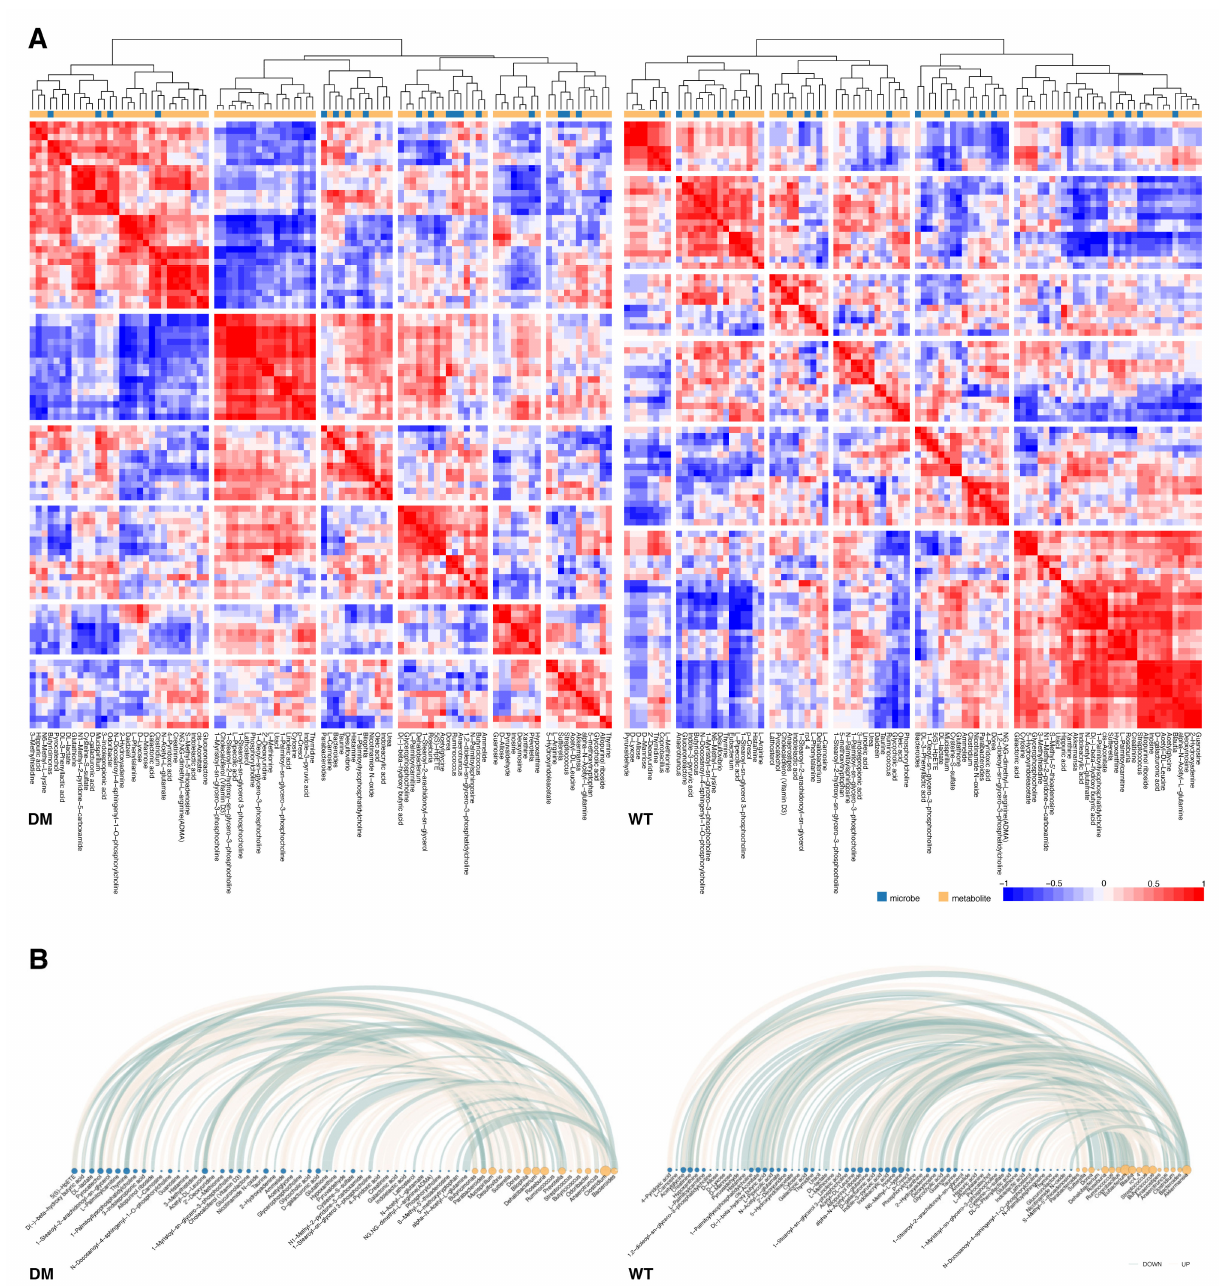
Figure 7. Correlation analysis of metabolites and microbes. ( A ) Heatmaps for correlation coefficients of metabolites and microbes in db/db and wt mice. Red represents positive correlation and blue represents negative correlation. ( B ) Arc diagrams for significantly correlated metabolite–microbe combinations. Light yellow edges represent significant positive correlations and light green edges represent significant negative correlations. Blue and yellow nodes represent microbes and metabo- lites,